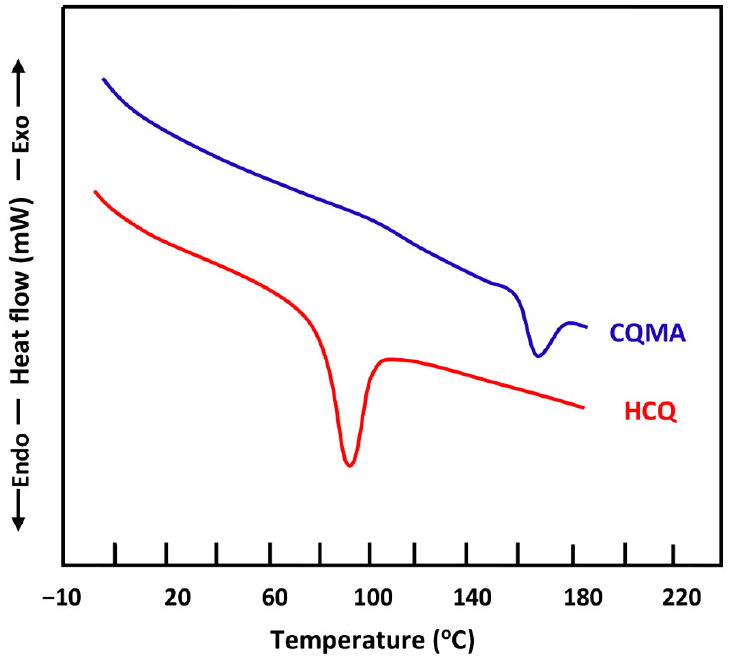
Figure 7. DSC thermograms of pure HCQ and CQMA monomers.